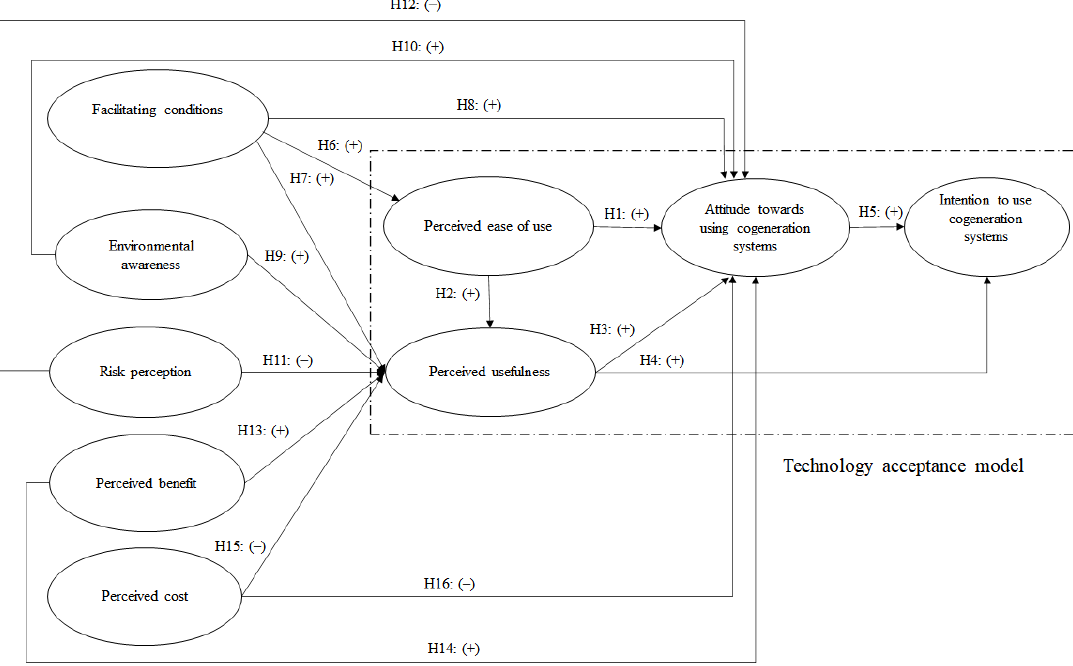
Figure 2. CoSAM to be tested in this study.